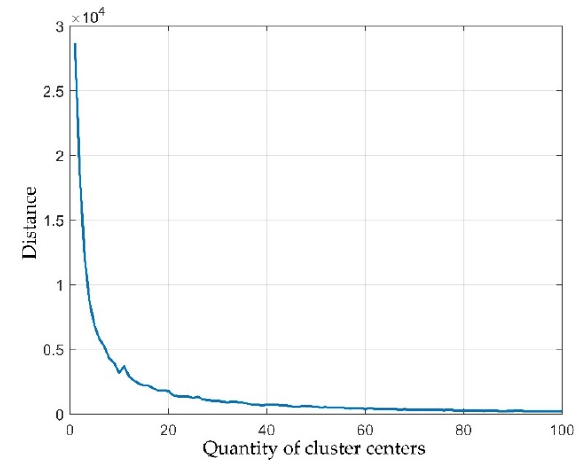
Figure 8. Clustering results of the historic fire data (K = 7).